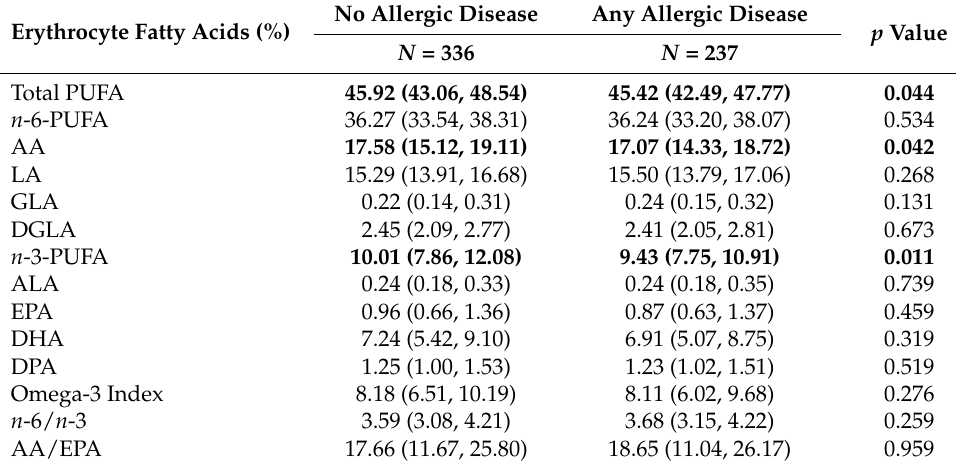
Table 2. Maternal erythrocyte fatty acids during pregnancy between the allergic disease group and the control group a .